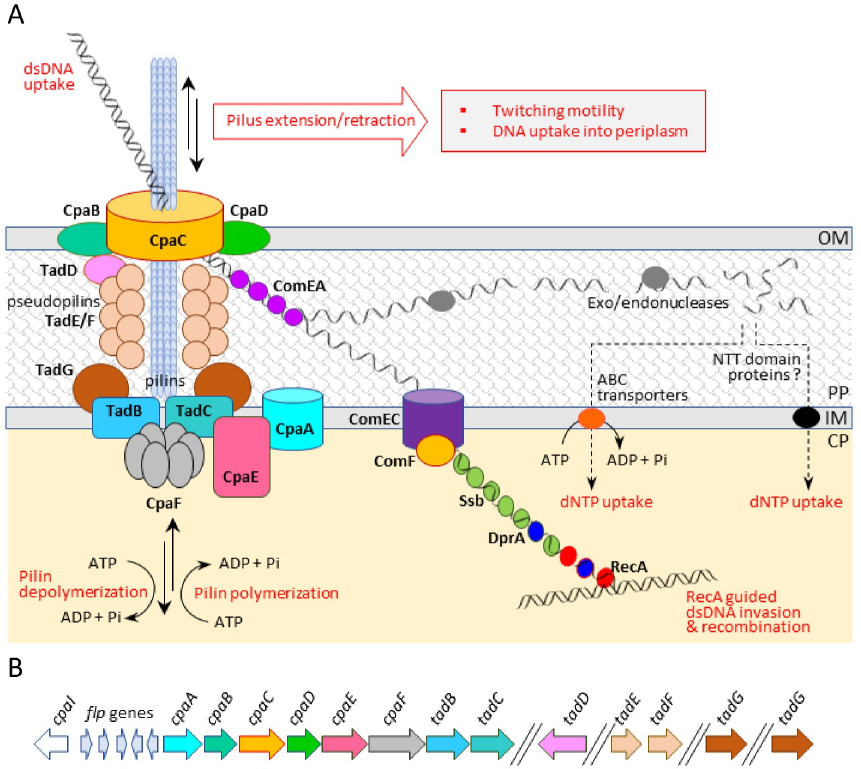
Fig 6. Tad pilus-mediated twitching motility is functionally coupled with periplasmic uptake of extracellular dsDNA. (A) A working model for Tad pilus-mediated uptake of extracellular dsDNA into periplasm and ComEC- mediated cytoplasmic translocation of ssDNA in naturally competent Lcr [26]. Bidirectional motor ATPase CpaF drives pilus extension and retraction via pilin polymerization and depolymerization causing both the twitching motility as well as DNA uptake. Schematic illustration of Tad pilus has been modified from Denise et al. [20]. (B) The structural components of the Tad pilus are named following Andrade and Wang [29]. Essential Tad pilus genes in Lcr encode the biogenesis ATPase ( tadZ / cpaE , B488_RS06245), motor ATPase ( tadA / cpaF , B488_RS06240), prepilin peptidase ( tadV / cpaA , B488_RS06265), inner membrane staging complex ( tadB / cpaG , B488_RS06235 and tadC / cpaH , B488_RS06230), secretin ( rcpA / cpaC , B488_RS06255), periplasmatic subunits ( tadG / cpaB , B488_RS06260 and rcpB / cpaD , B488_RS06250), inner membrane anchor ( rcpC / tadG , B488_RS05235) and pilotin ( tadD / cpaO , B488_RS05560). The genes encoding the DNA translocation machinery include dsDNA receptor ( comEA , B488_RS00175), inner membrane channel protein ( comEC , B488_RS05330), ATP-dependent translocase ( comF , B488_RS05095), ssDNA binding proteins ( ssb , B488_RS01885), DNA processing protein A ( dprA , B488_RS04595) and the recombinase protein ( recA , B488_RS02195). While Lcr is naturally competent for transformation, in this model, all Liberibacters are presumed to likely assimilate extracellular dsDNA as a food source. Except for comEC , rest of the Tad pilus and natural competence components are well conserved between Lcr and ‘ Ca . Liberibacter’ spp. Canonical NTT domain containing nucleotide transporter proteins remain to be identified in Lcr and/or ‘ Ca . Liberibacter’ spp. Abbreviations: OM, outer membrane; IM, inner membrane; PP, periplasm; CP, cytoplasm.